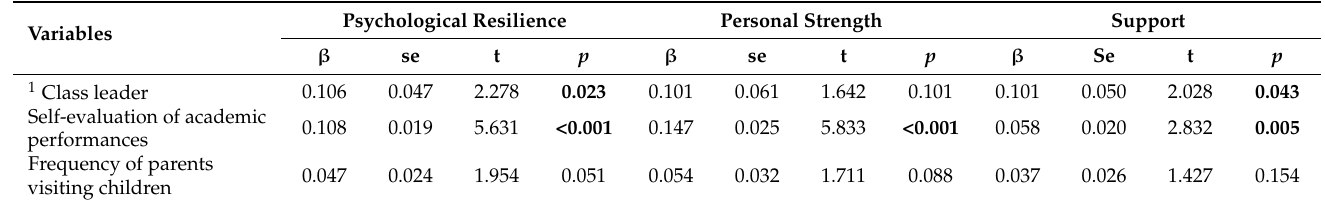
Table 5. Multivariable linear regression analysis of factors associated with psychological resilience among left-behind